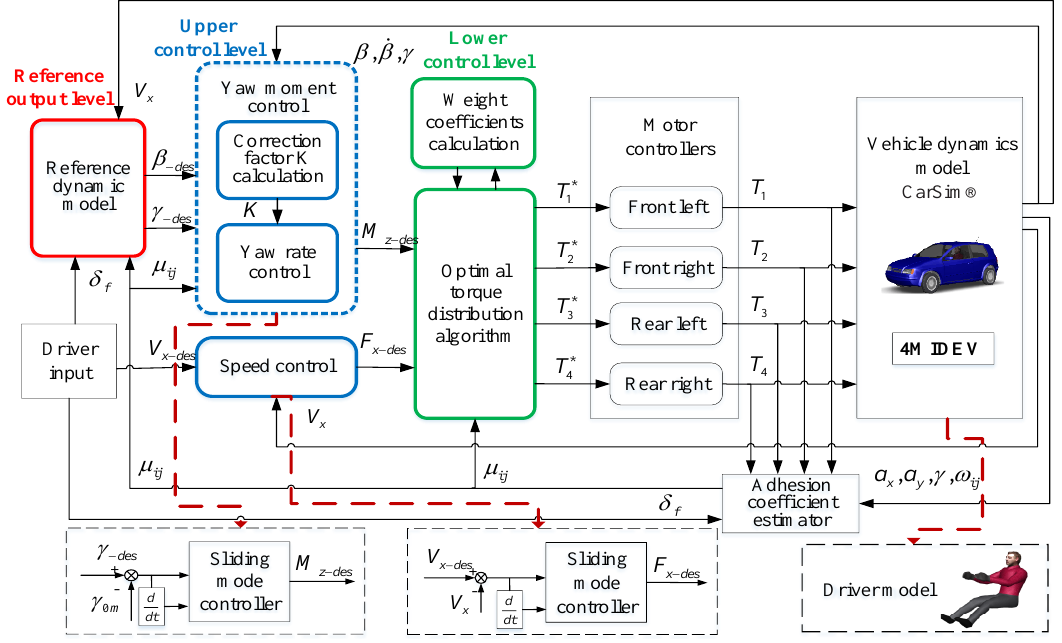
Figure 3. The configuration of hierarchical stability control strategy.